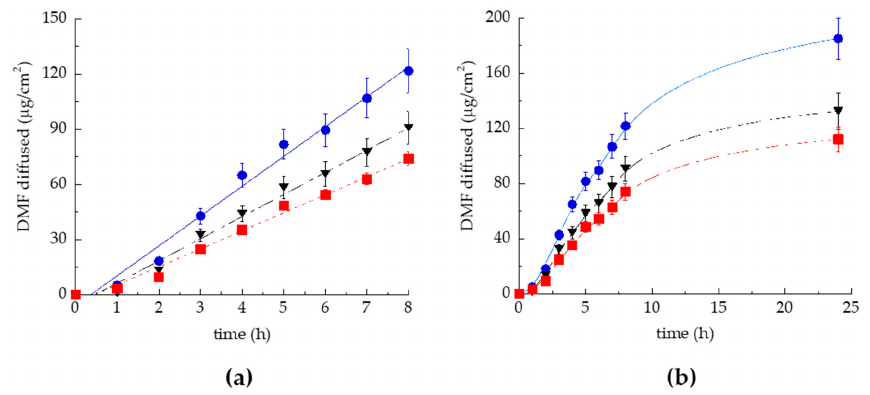
Table 4. IVPT parameters of the indicated forms, as determined by Franz cells associated with Strat- M ® .